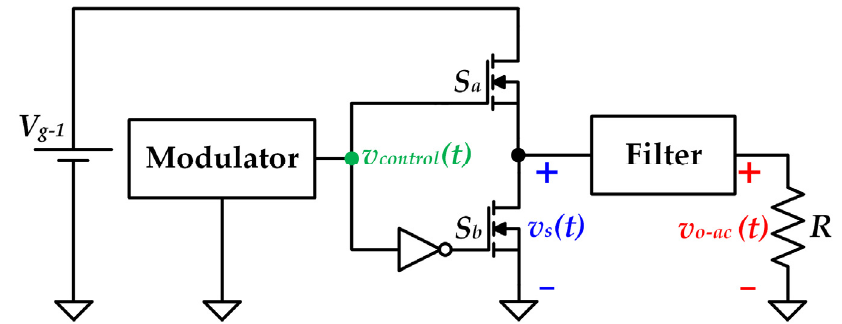
Figure 2. General scheme of a Class D SMPA.